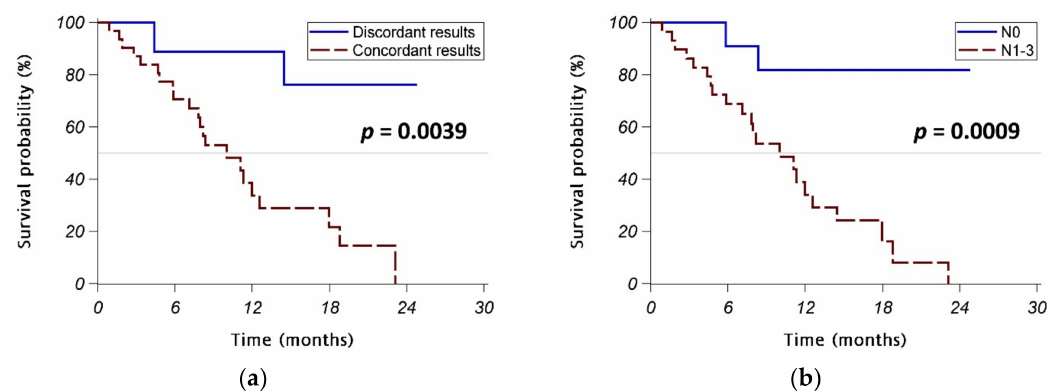
Figure 2. Progression-free survival (PFS) in stage IV patients receiving first-line EGFR TKIs. ( a ) Patients with concordant EGFR mutation test results in liquid / tissue biopsy vs. those with discordant results. ( b ) Patients with lymph node involvement (N1–3 disease) vs. those without lymph node involvement (N0 disease). Abbreviations: EGFR = epidermal growth factor receptor; ECOG = Eastern Cooperative Oncology Group; TKI = tyrosine kinase